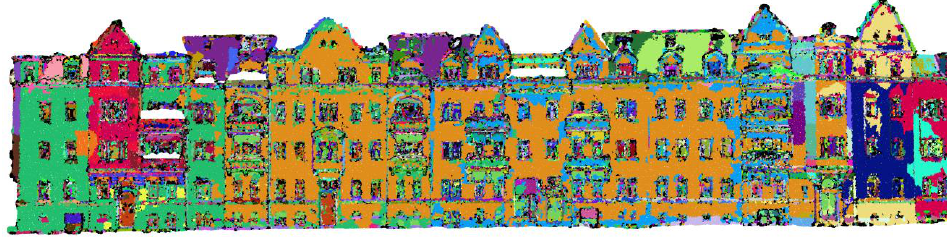
Figure 3. Hybrid region growing result